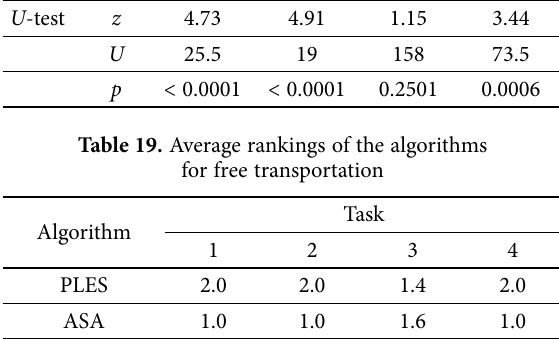
Table 17. Performance of the PLES and the ASA for free